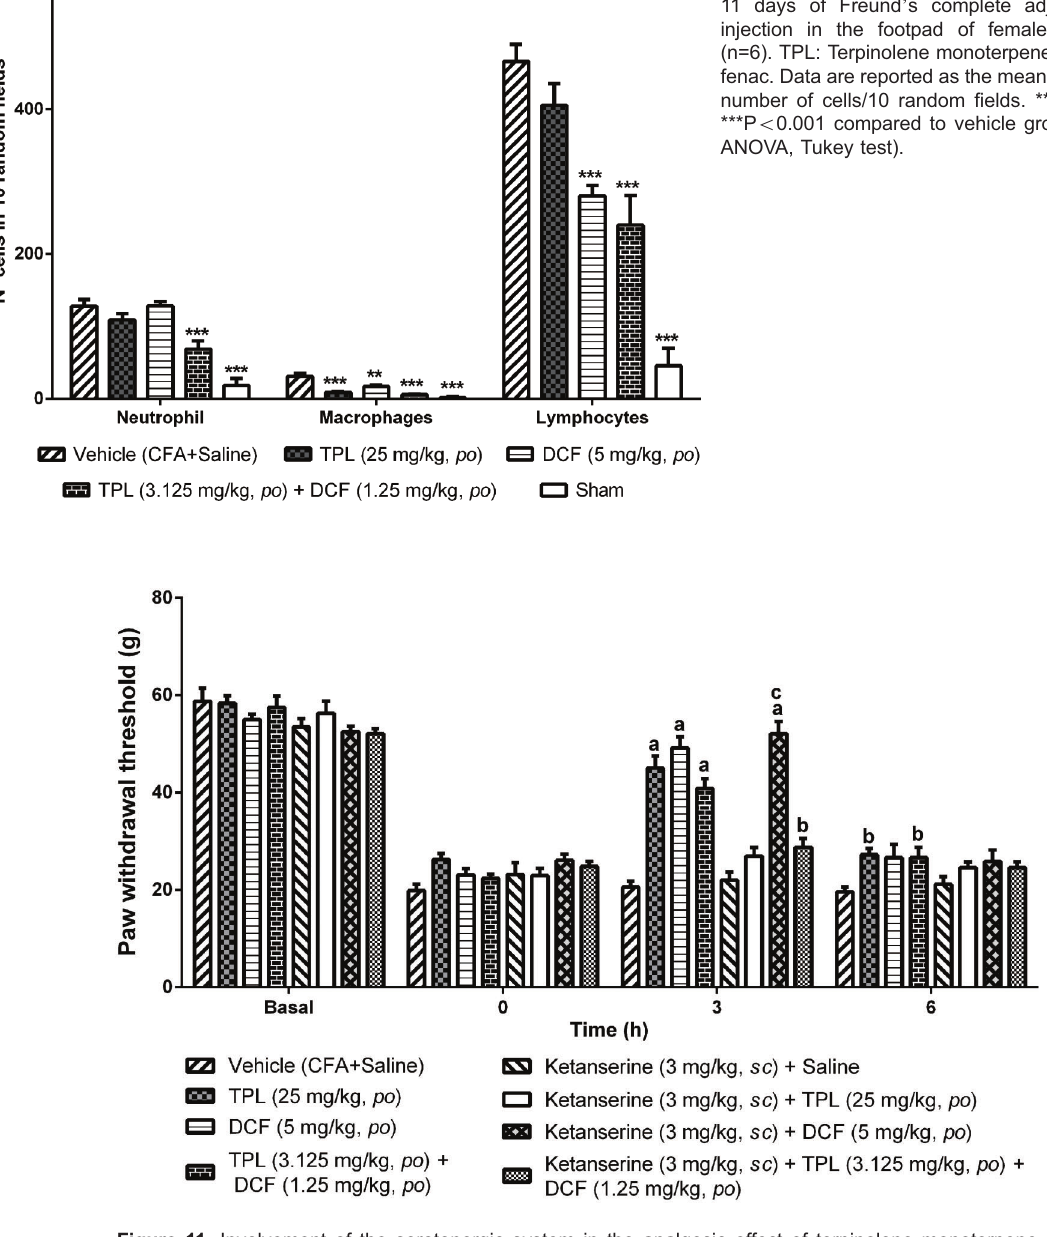
Figure 10. Differential leukocyte counts after 11 days of Freund ’ s complete adjuvant (CFA) injection in the footpad of female Wistar rats (n=6). TPL: Terpinolene monoterpene; DCF: diclo- fenac. Data are reported as the mean ± SEM of the number of cells/10 random fi elds. **P o 0.01 and